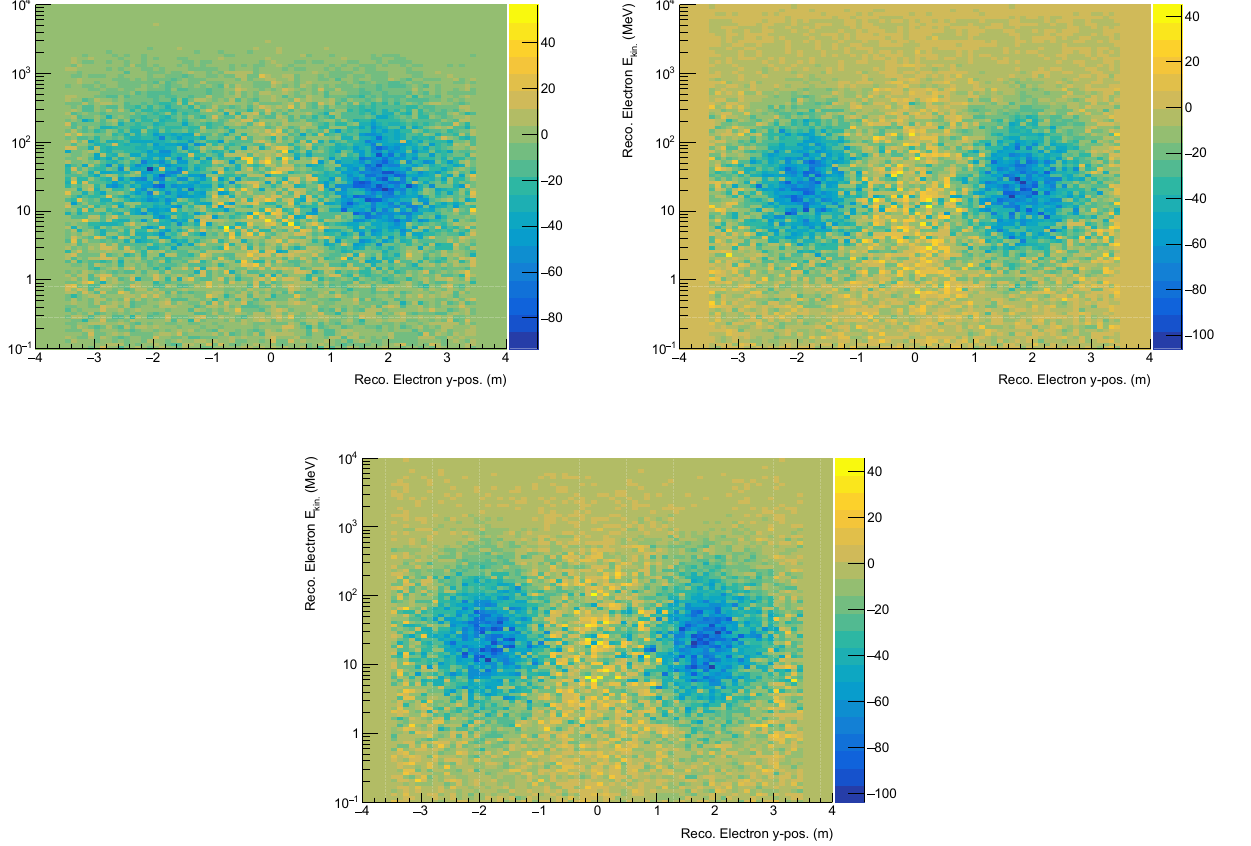
Figure 9. The distribution of the kinetic energy E kin . as a function of the y -position of the reconstructed electrons in the lower detector plane. The materials analyzed are Magnesium and Cesium ( upper row ), Chromium and Ytterbium ( middle row ), as well as Molybdenum and Lead ( bottom row ). The hits from the empty container are